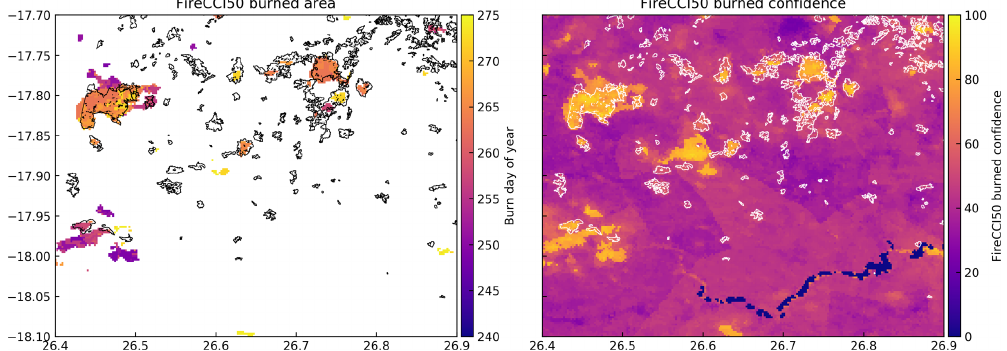
Figure 10. Example of the pixel-level uncertainties (burned confidence) provided with the FireCCI50 product. The area covers northern Zimbabwe for the period September 2008. Landsat-derived burned area is